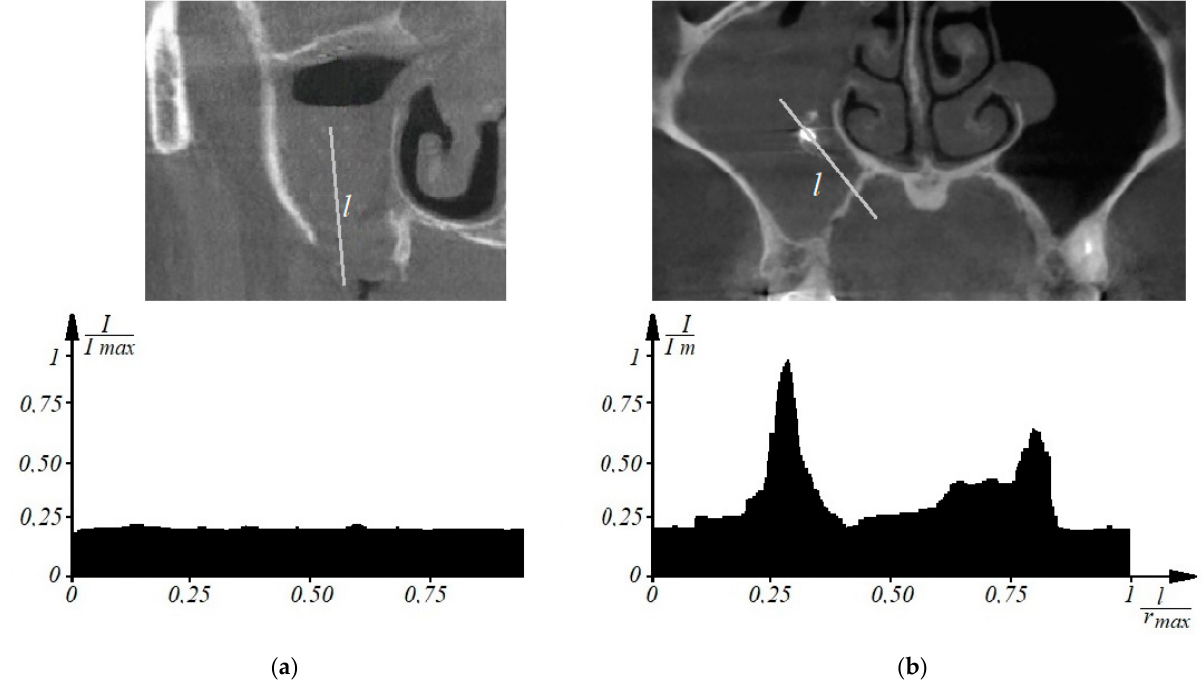
Figure 2. This is a figure. Schemes follow the same formatting. If there are multiple panels, they should be listed as: ( a ) Description of what is contained in the first panel; ( b ) Description of what is contained in the second panel. Figures should be placed in the main text near to the first time they are cited. A caption on a single line should be centered.